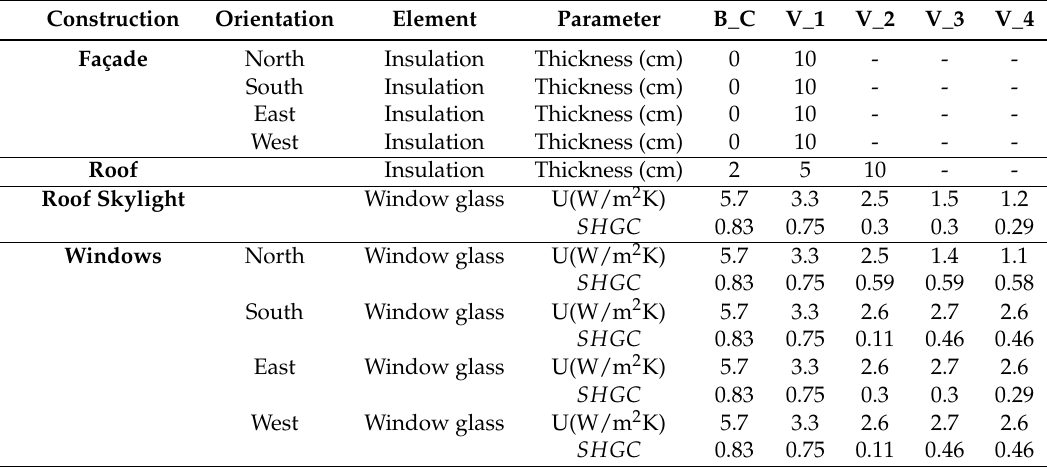
Table 2. Different parameters for the envelope